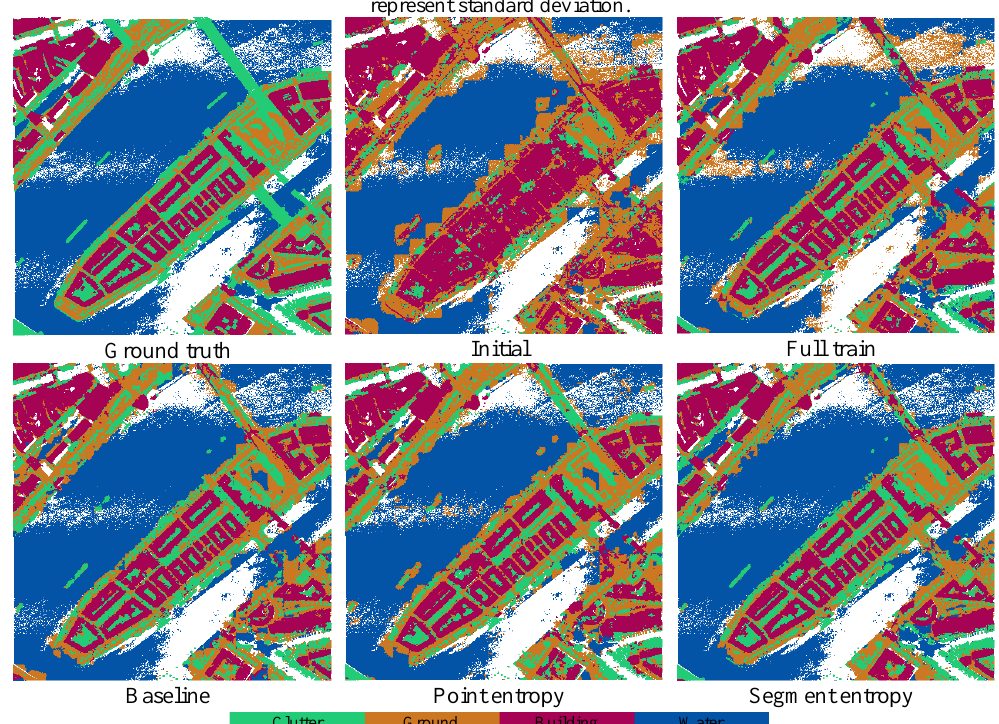
Water Figure 6. Qualitative comparison of different model performance. The first row shows the ground truth labels, model performances trained on initial data and full training data. The second row shows final model performances trained on data iteratively selected by baseline, point entropy and segment entropy